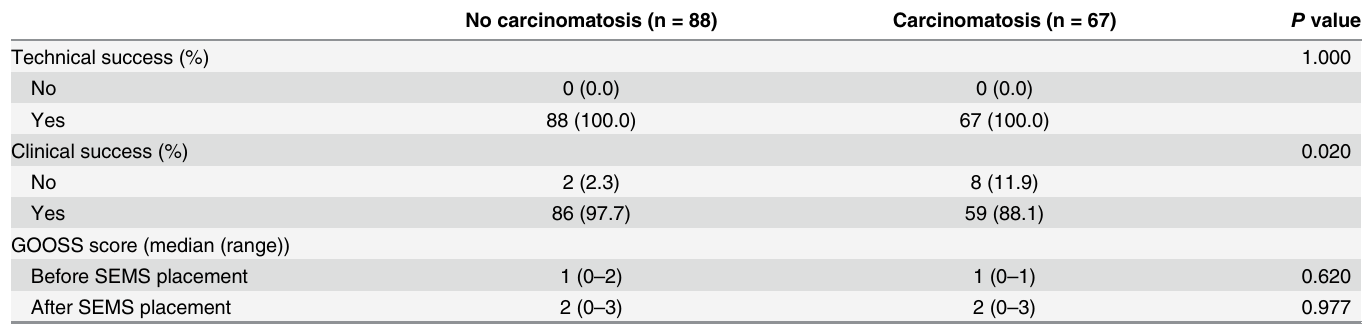
Table 2. Technical and clinical success rates of self-expandable metallic stent placement according to the presence of carcinomatosis.